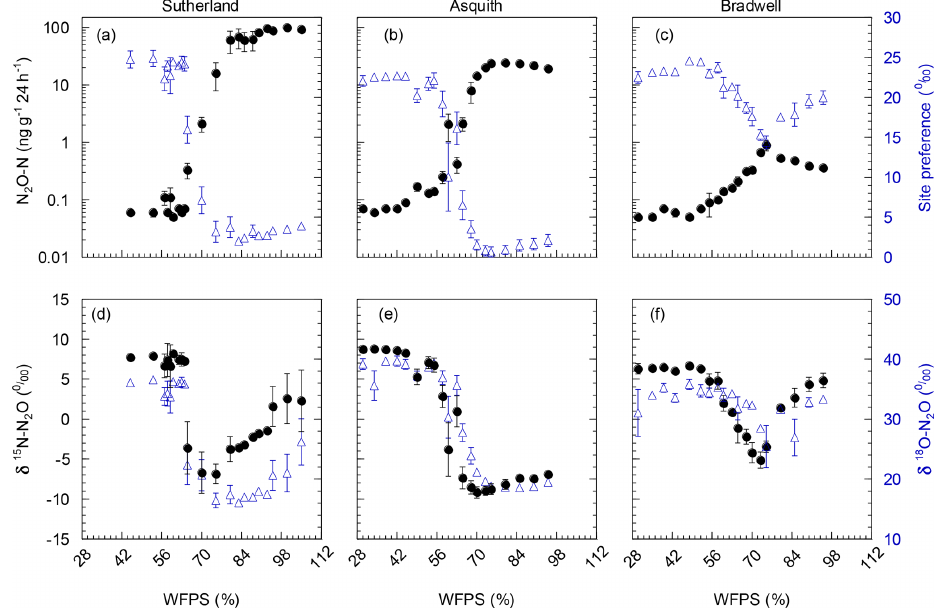
Figure 2. (a, b, c) N 2 O-N production as influenced by soil water-filled pore space (WFPS; black; left axis); corresponding 15 N 2 O isotopomer site preference (SP; blue; right axis). (d, e, f) δ bulk 15 N (black; left axis) and δ 18 O (blue; right axis) of emitted N 2 O as influenced by soil water-filled pore space (WFPS). Note: N 2 O emissions were plotted on a log 10 scale to accommodate the large range in emissions from the different soils. Data points represent means ( n = 4), and bars represent the standard errors. Table 2. Linear regressions between 15 N site preference and soil water-filled pore space (%) during three soil moisture regions for each soil type (i) before the transition from nitrification, (ii) during the transition from nitrification to denitrification, and (iii) after the transition to